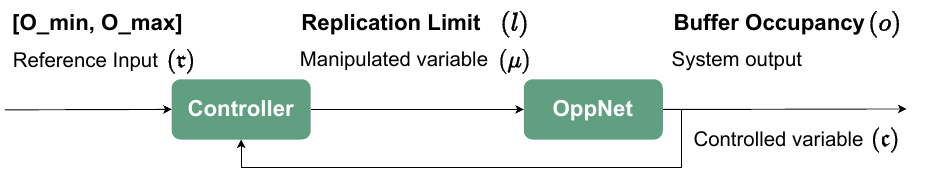
Figure 5. Closed-loop control system for congestion